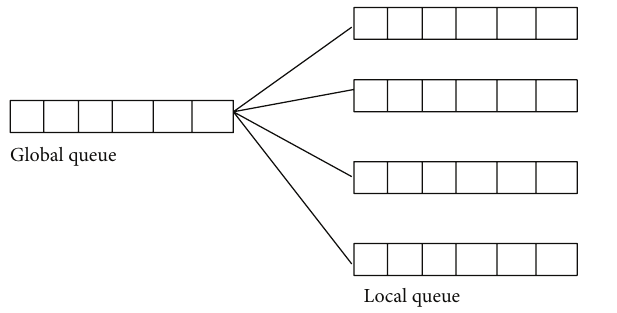
Figure 1: Proposed scheduling system.